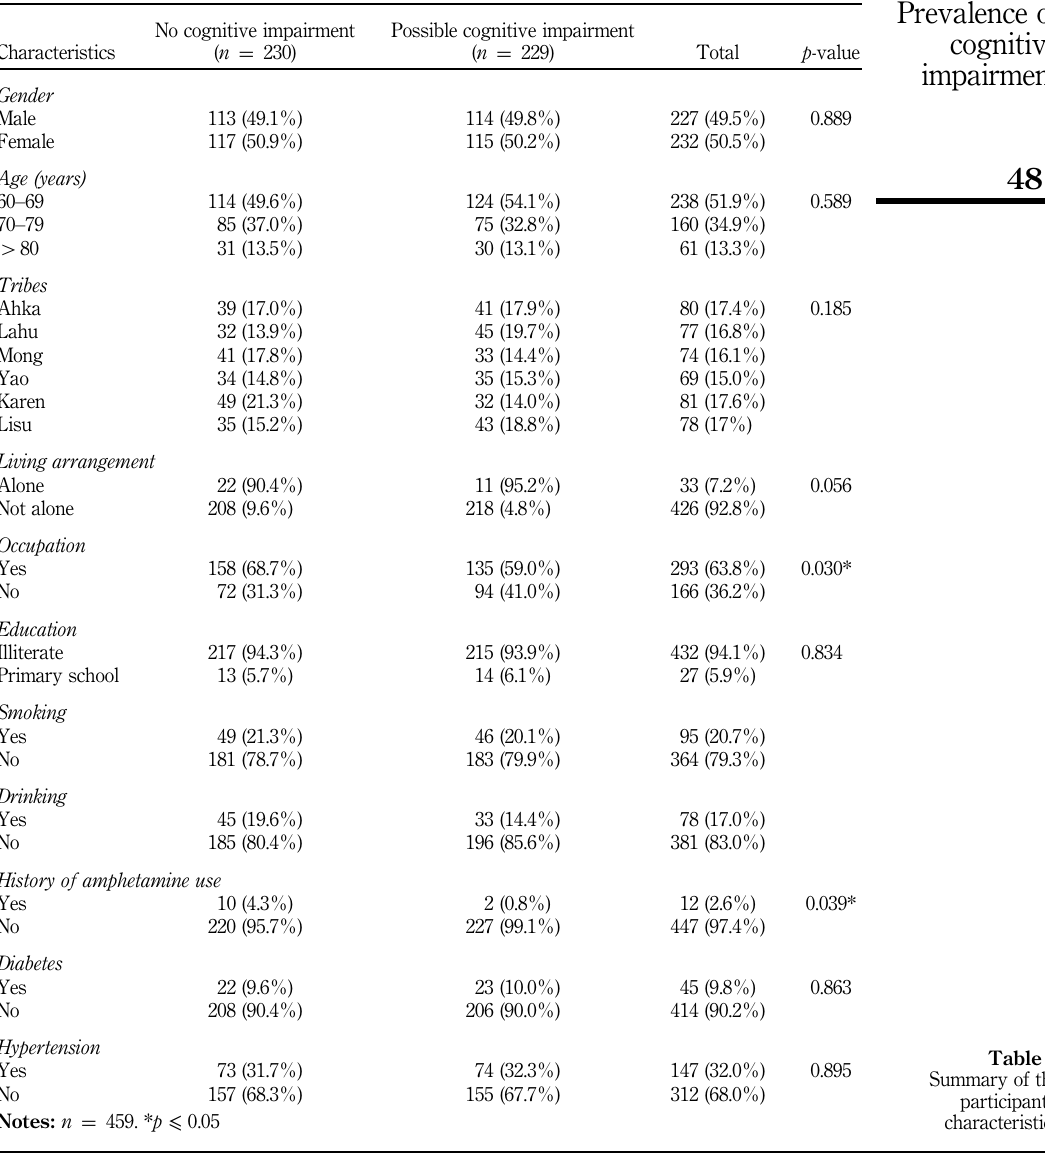
Table II displaying the univariate logistic regression revealed that the characteristics of participants who were more likely to be reported as having possible cognitive impairment were those with no occupation (OR ¼ 1.49, 95% CI 1.10, 2.03) and had a history of